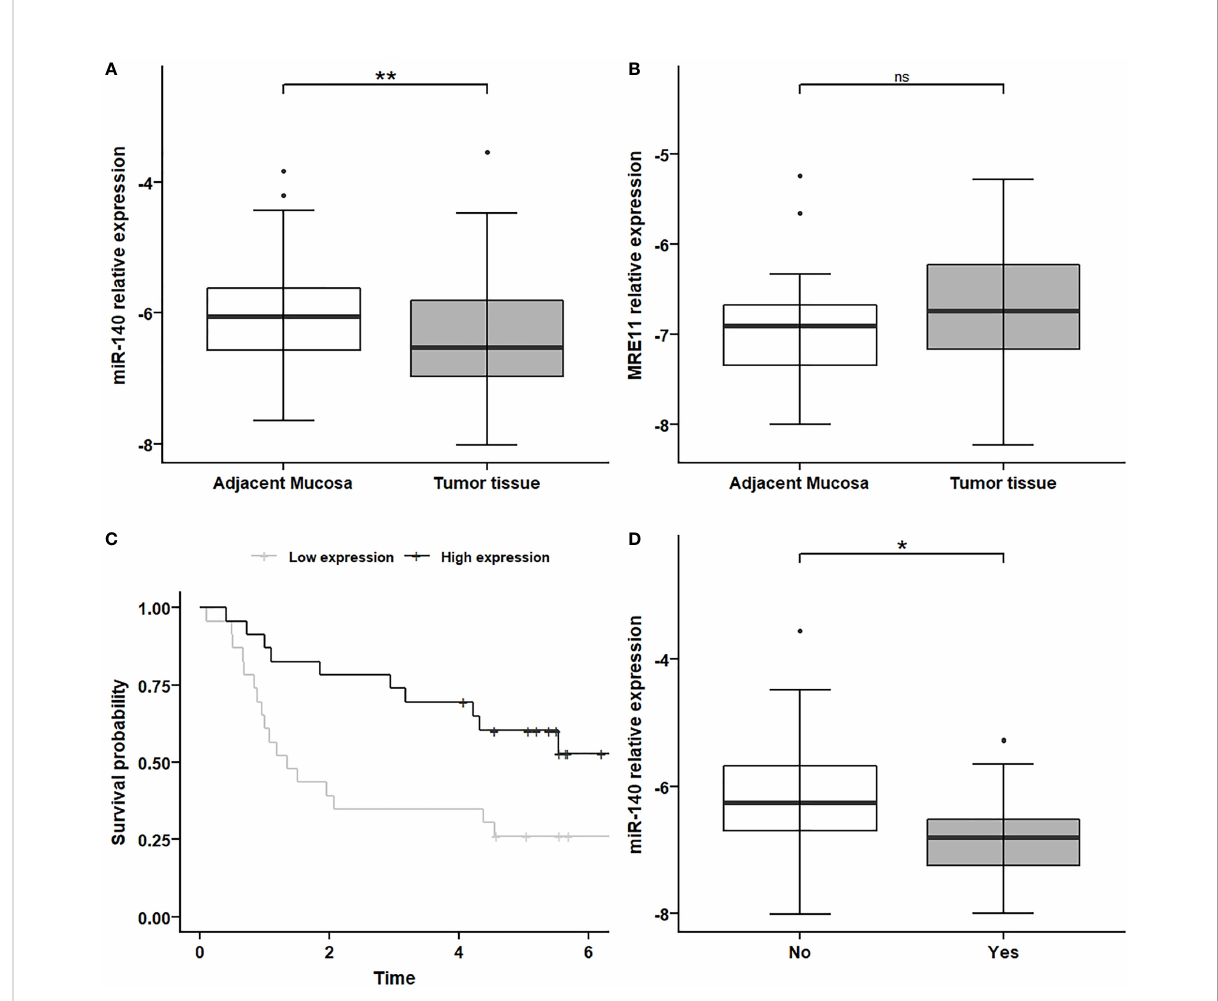
FIGURE 2 MiR-140 downregulation and association with PFS and metastatic CRC phenotype. (A) Relative expression of miR-140 is decreased in tumor tissues compared to non-adjacent mucosa (p = 0.009). (B) Relative expression of MRE11 in non-signi fi cantly increased in tumor tissue (p = 0.11). (C) Kaplan – Meier analysis showed that lower expression of miR-140 in tumor tissue is associated with poor PFS (p = 0.017). (D) Decreased relative expression of miR-140 is associated with the metastatic phenotype of CRC (p = 0.023). *p ≤ 0.05, **p ≤ 0.01. PFS, progression-free survival; CRC, colorectal cancer. ns = p>0.05 = non-signi fi